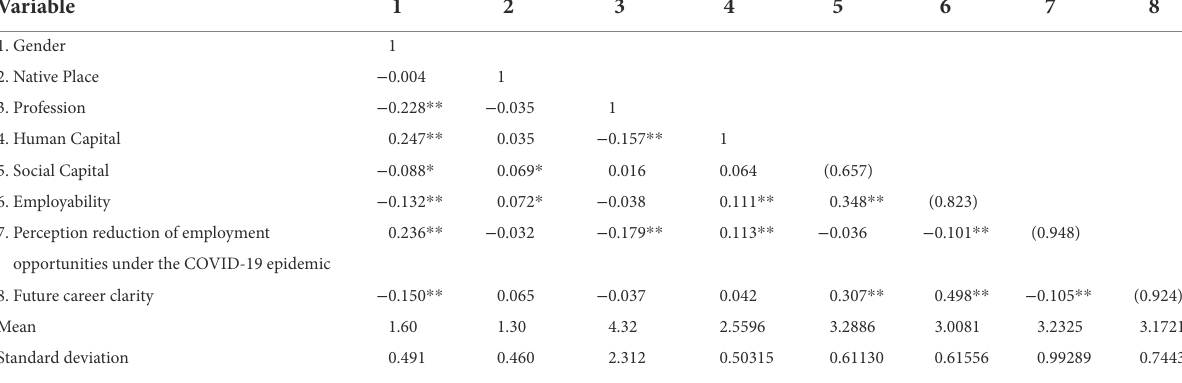
TABLE 2 Means, standard deviations, and correlation analysis results of various variables ( n = 810).